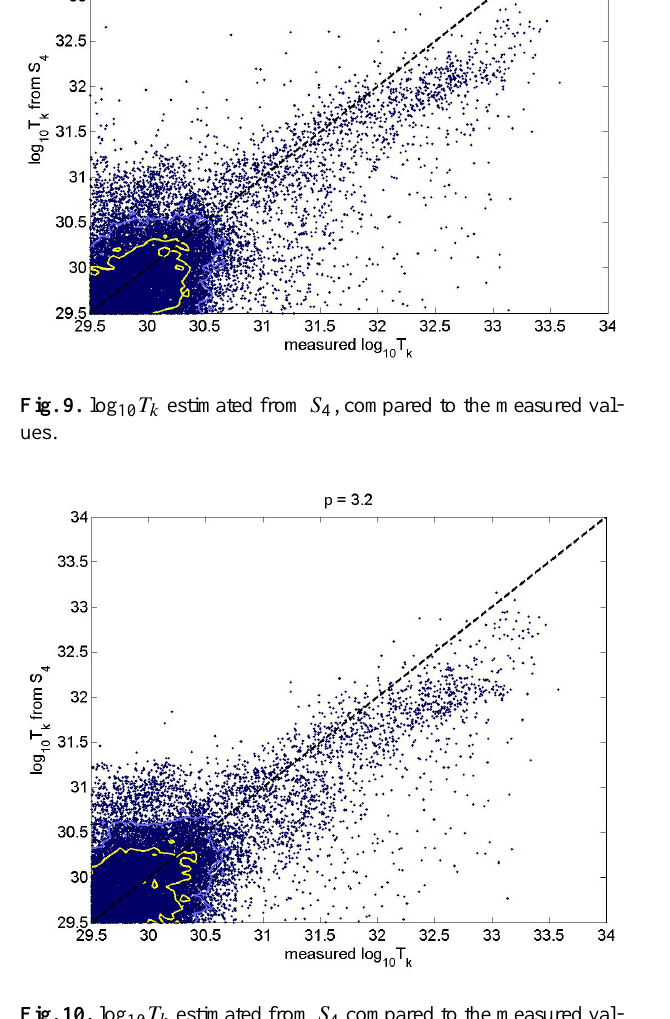
Fig. 10. log 10 T k estimated from S 4 compared to the measured val- ues, using a constant p =3.2.